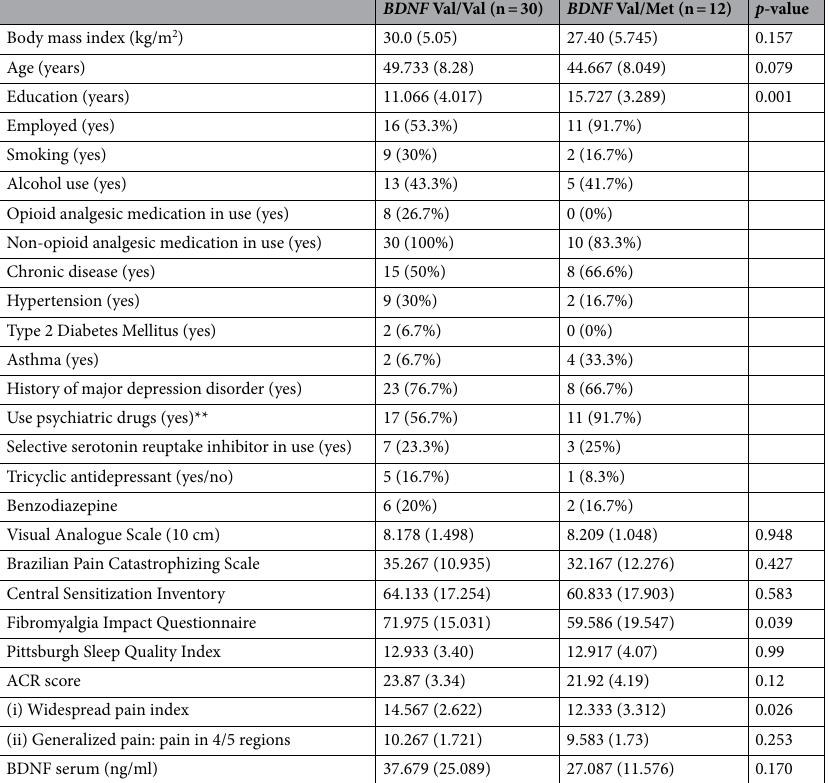
Table 1. Demographic and characteristics according to the BDNF genotype. Data are presented as mean and standard deviation (SD) or frequency (%) (n = 42). BDNF brain-derived neurotrophic factor . Val/Val Val66Val homozygous . Val/Met Val66Met heterozygous . ACR score American College of Rheumatology score for fibromyalgia